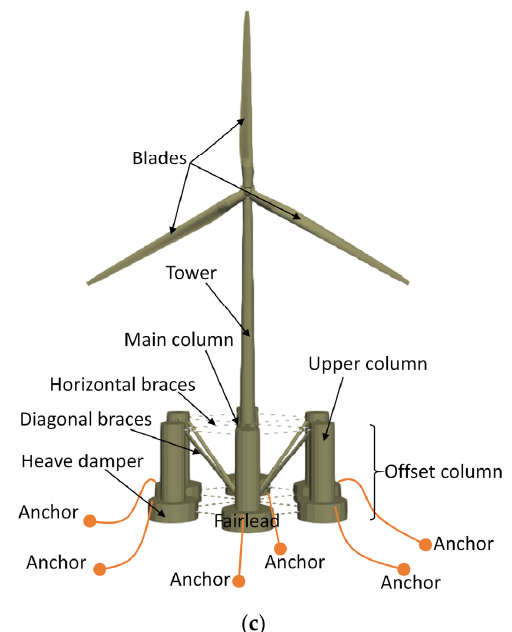
Figure 4. Sketch of the semi-submersible floating system with six offset columns (Model 2), ( a ) side view, ( b ) bird view, and ( c ) isometric view of semi-submersible floating platform. The six DFO are defined as surge, sway, heave, roll, pitch, and yaw. For all simulations presented, the direction of wave propagation is aligned with the platform, which is in the surge direction.